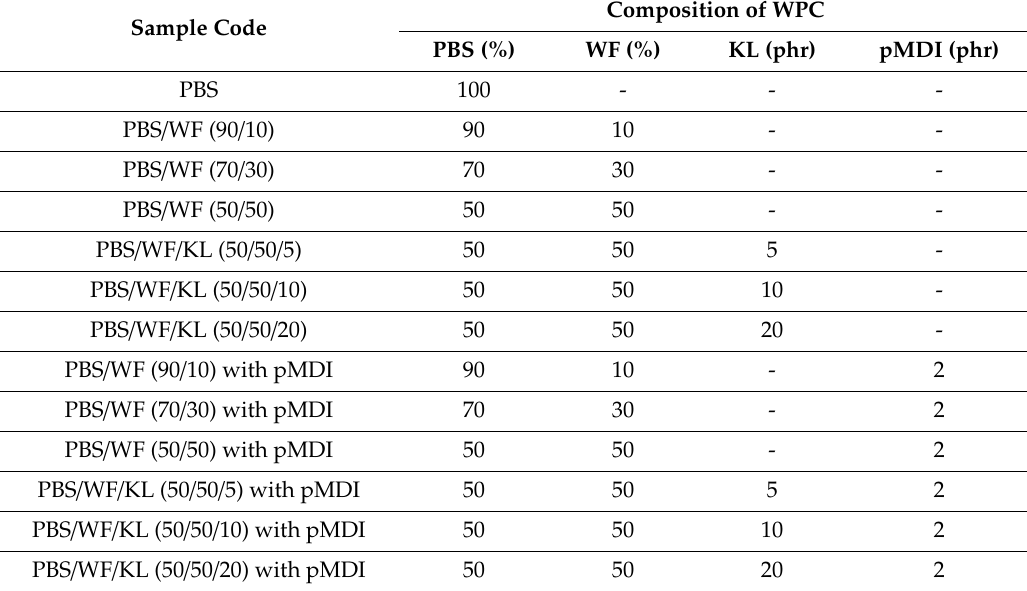
Table 1. Composite material formulation of the wood-plastic composite (WPC) in weight